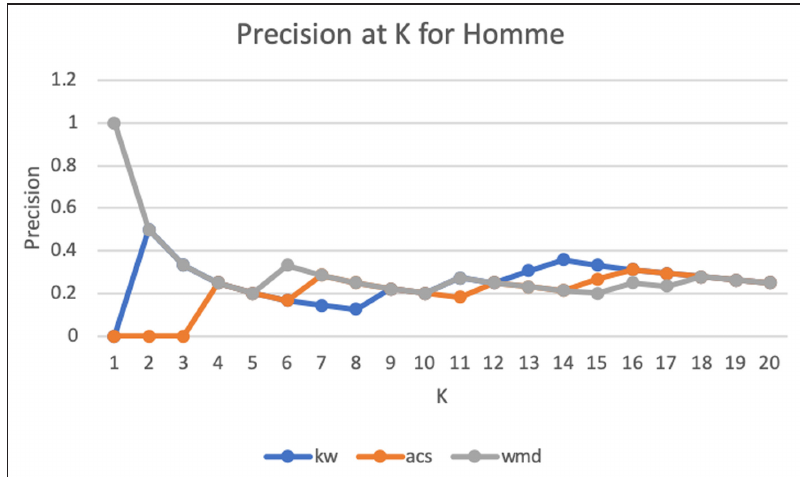
Figure 8: P@K for